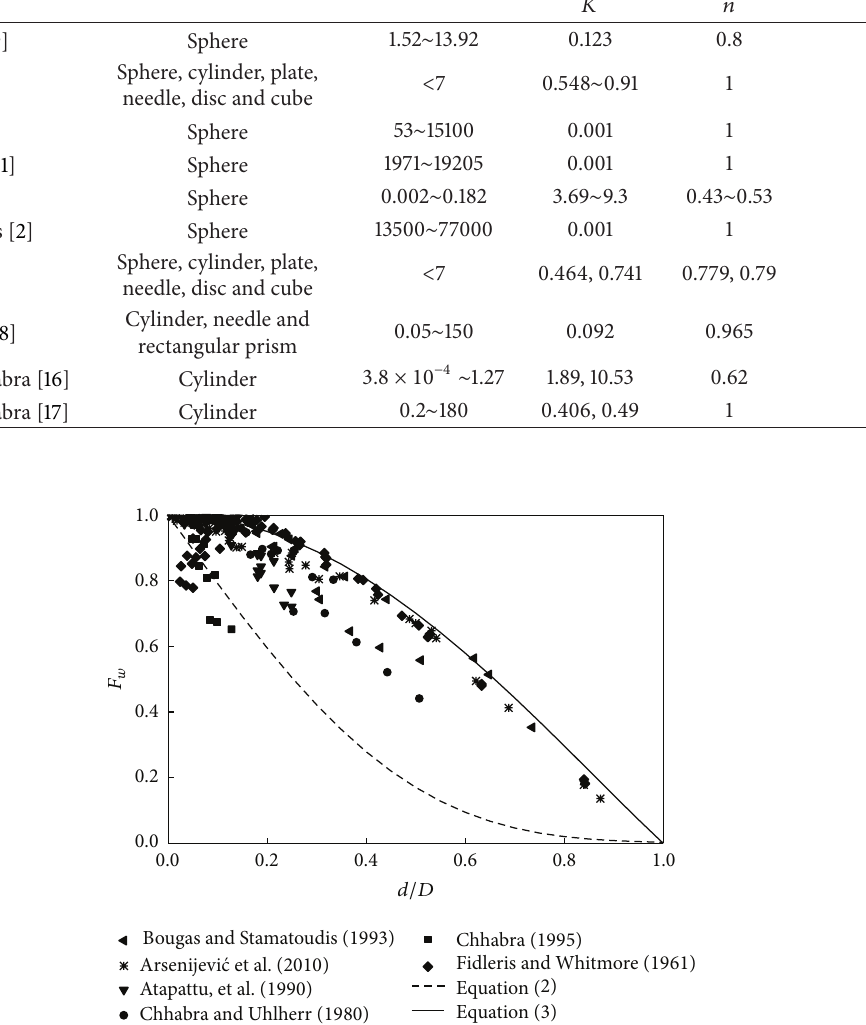
Figure 1: Dependence of wall factors for spheres on the sphere-tube diameter